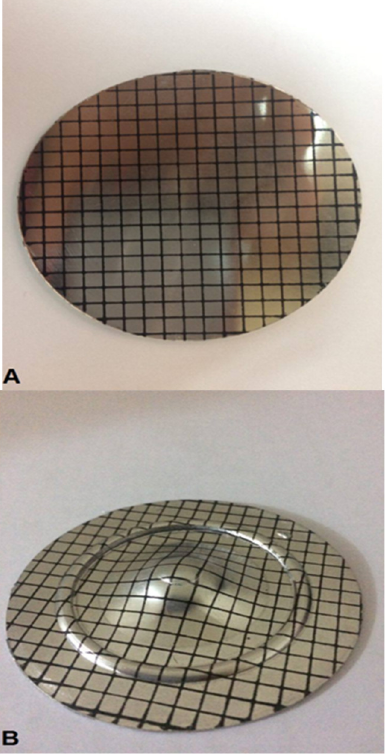
Fig. 4. Stretching forming equipments used. a) physical tools representation, b) assembly view representation.